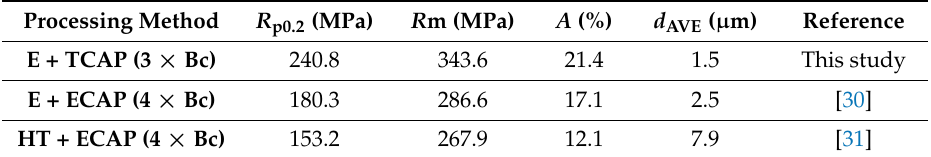
Table 3. Tensile properties and average grain size of AZ61 magnesium alloy subjected to different SPD